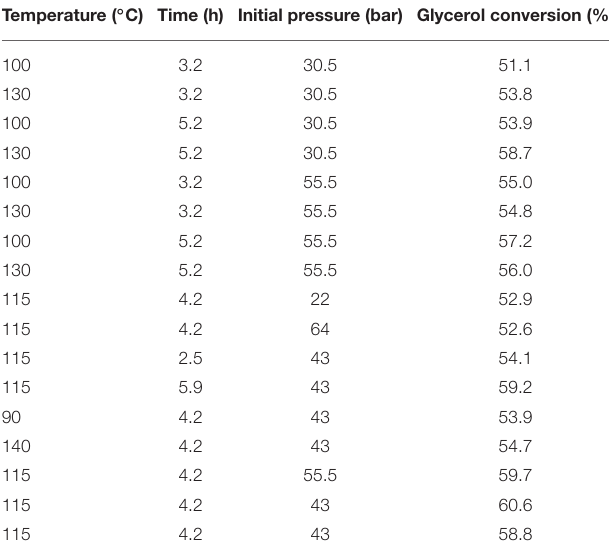
TABLE 1 | Results of the Central Composite